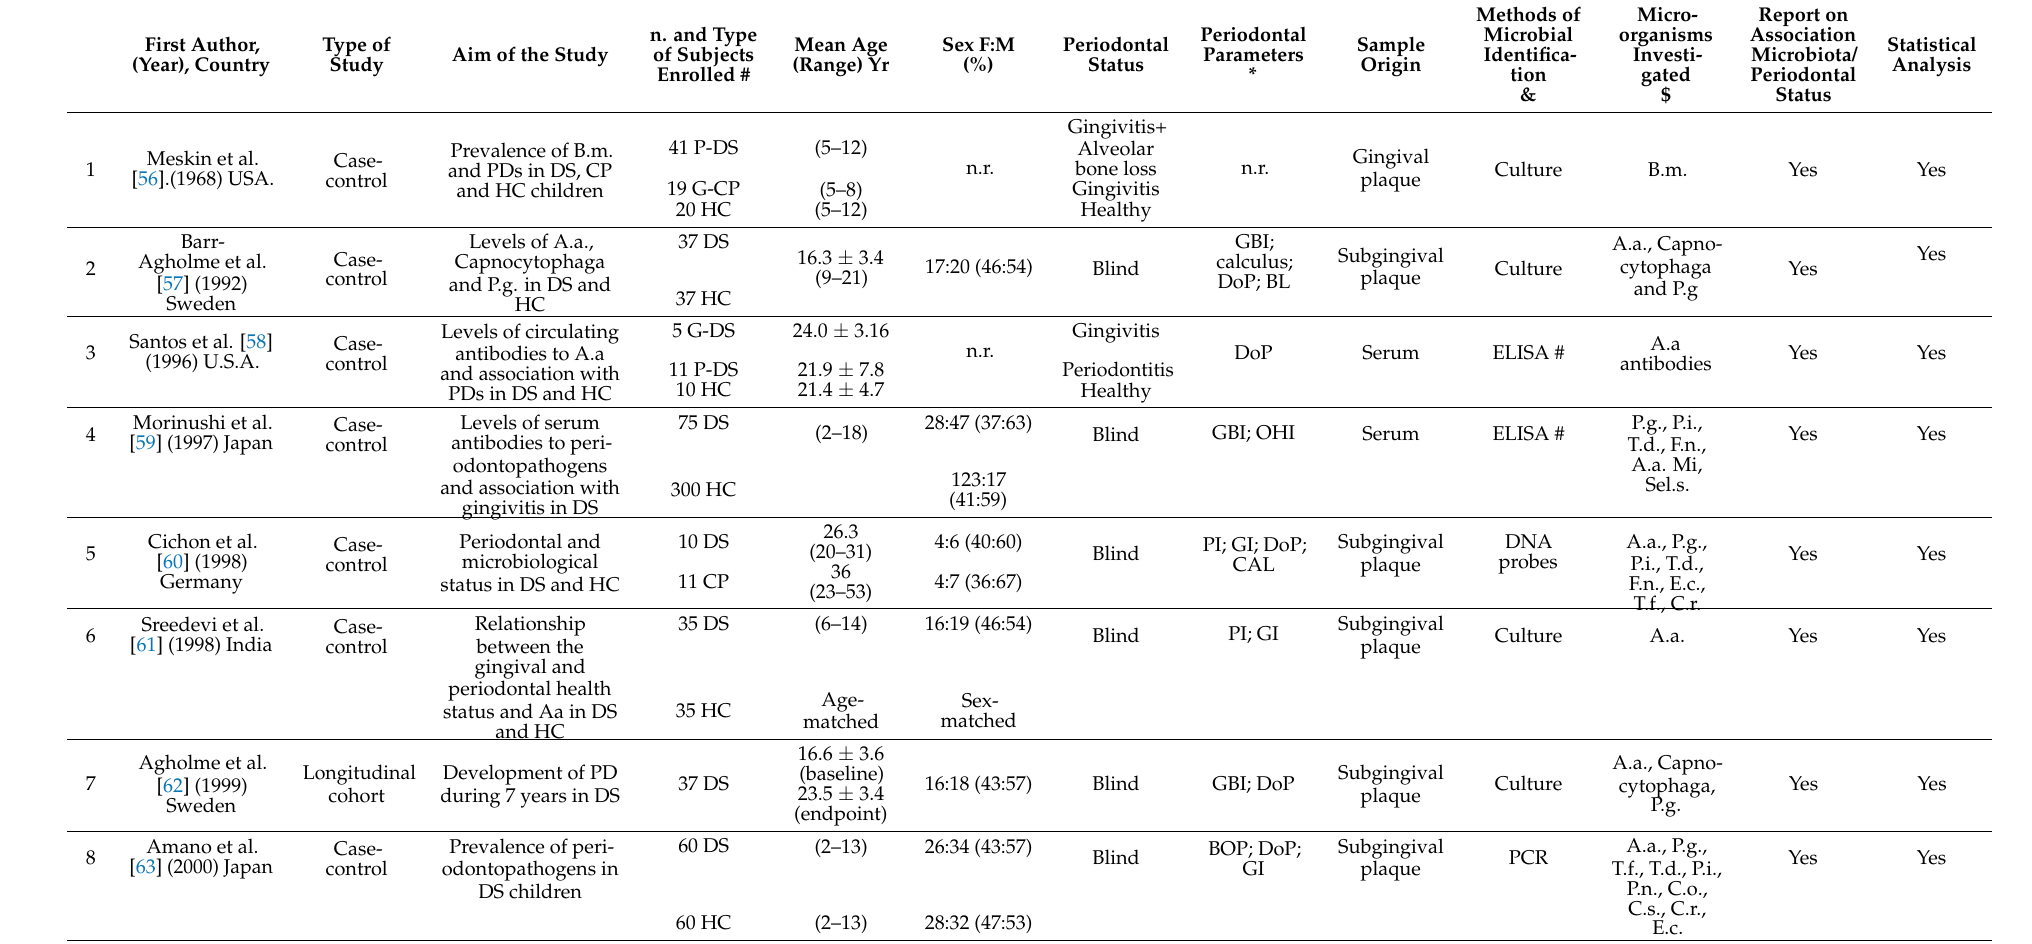
Table 3. Main characteristics of the studies